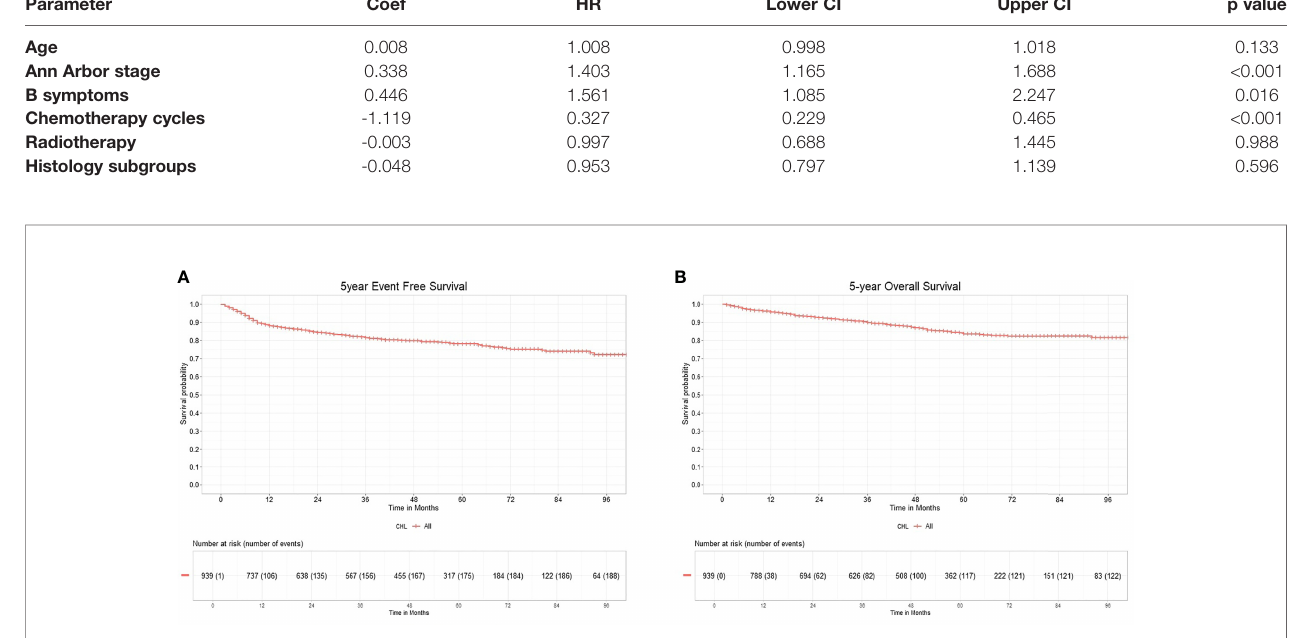
FIGURE 2 | (A) 5-year event free survival of classical Hodgkin lymphoma. (B) 5-year overall survival of classical Hodgkin